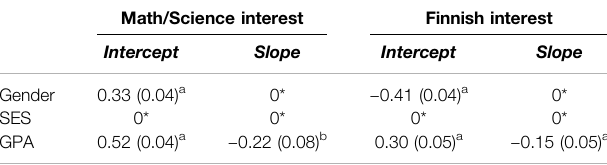
TABLE 6 | Antecedents of the latent growth components of the parallel process LGC model (standardized estimates, standard errors in the parentheses) among Finnish secondary school students.